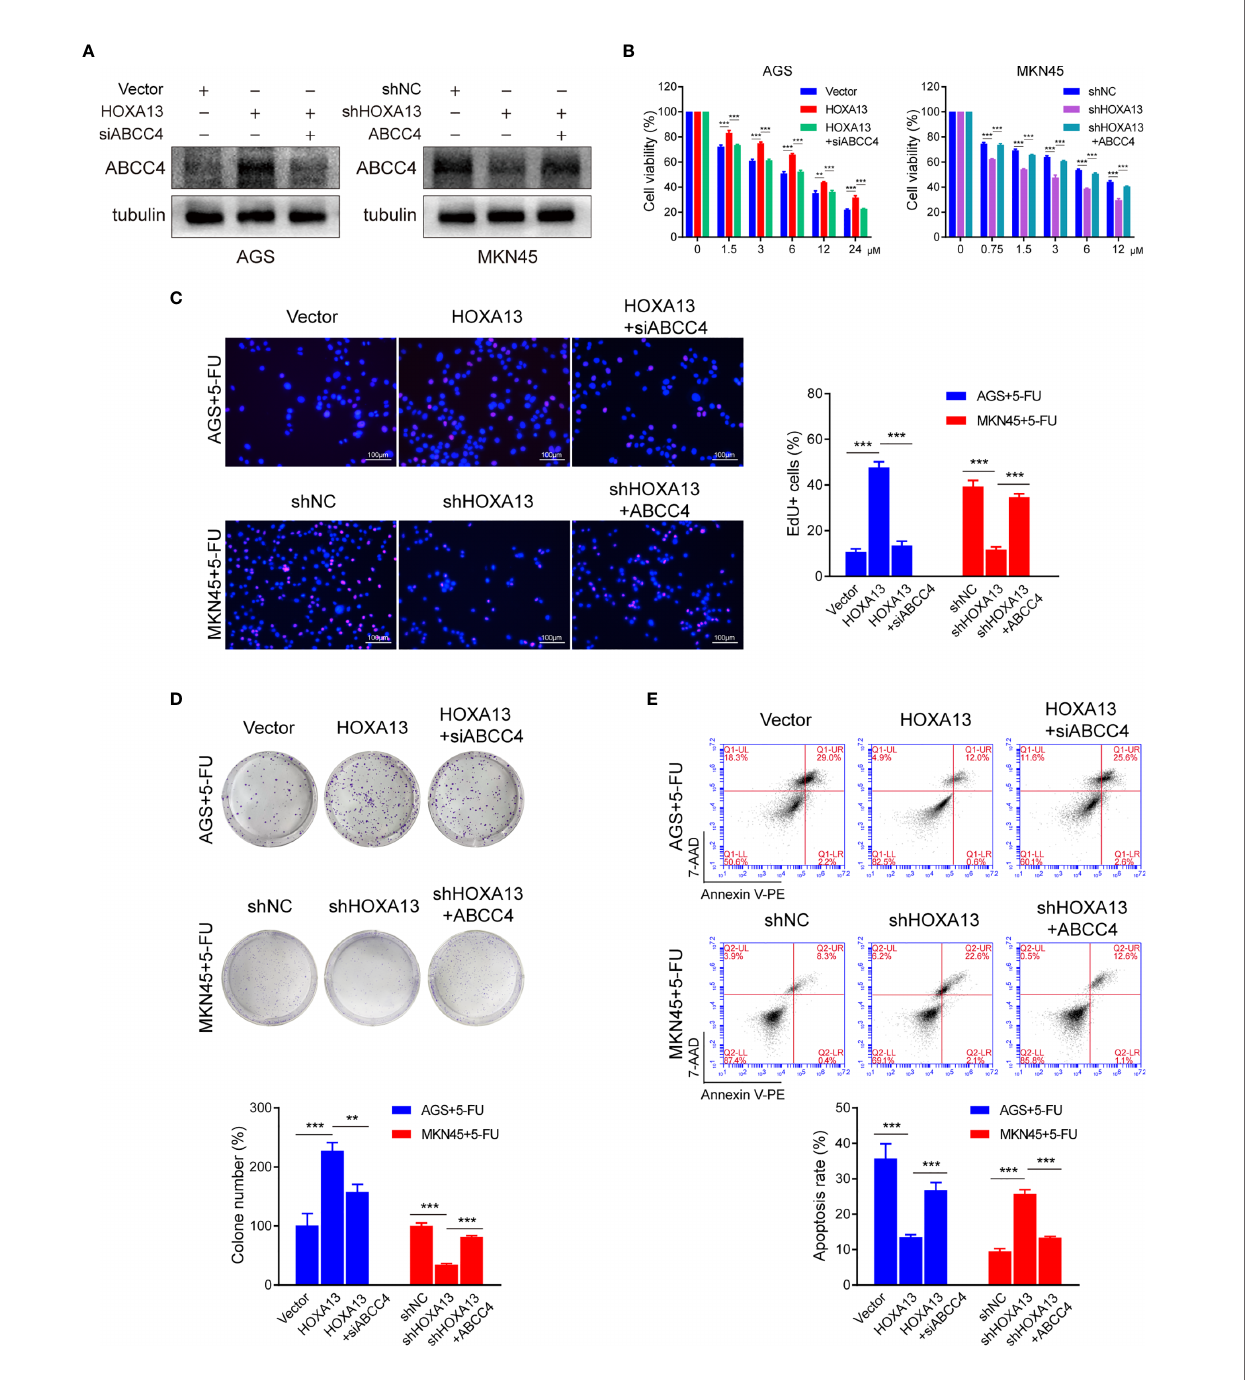
FIGURE 5 | siABCC4 reverses HOXA13-mediated 5-FU resistance in GC cells. (A) The protein levels of ABCC4 were detected in AGS cells including Vector, HOXA13 and HOXA13 + siABCC4 groups and MKN45 cells including shNC, shHOXA13 and shHOXA13 + ABCC4 groups. (B – D) CCK-8 assays, EdU assays and colony formation assays revealed that depletion of ABCC4 enhanced anti-proliferative effect of 5-FU in HOXA13-overexpressing cells, while overexpression of ABCC4 weakened that of 5-FU in HOXA13 knockdown cells. Magni fi cation ×200. (E) After inhibiting of ABCC4 expression, the apoptotic levels of HOXA13-overexpressing cells induced by 5-FU was increased, while ABCC4 overexpression in HOXA13 knockdown cells had the same rescue effect. ** P < 0.01, *** P <